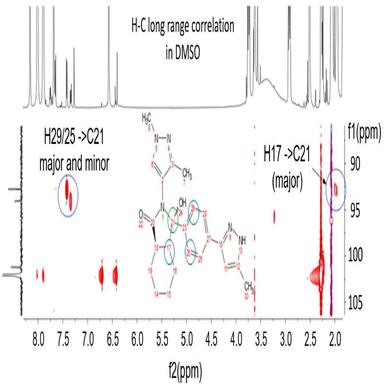
Expansion of the 1H-13C long-range J-correlated spectrum of AZ13581258 showing correlations from the quaternary carbons in the ring-closed tautomeric forms, correlating to the para-substituted aromatic and the cyclohexyl residues.